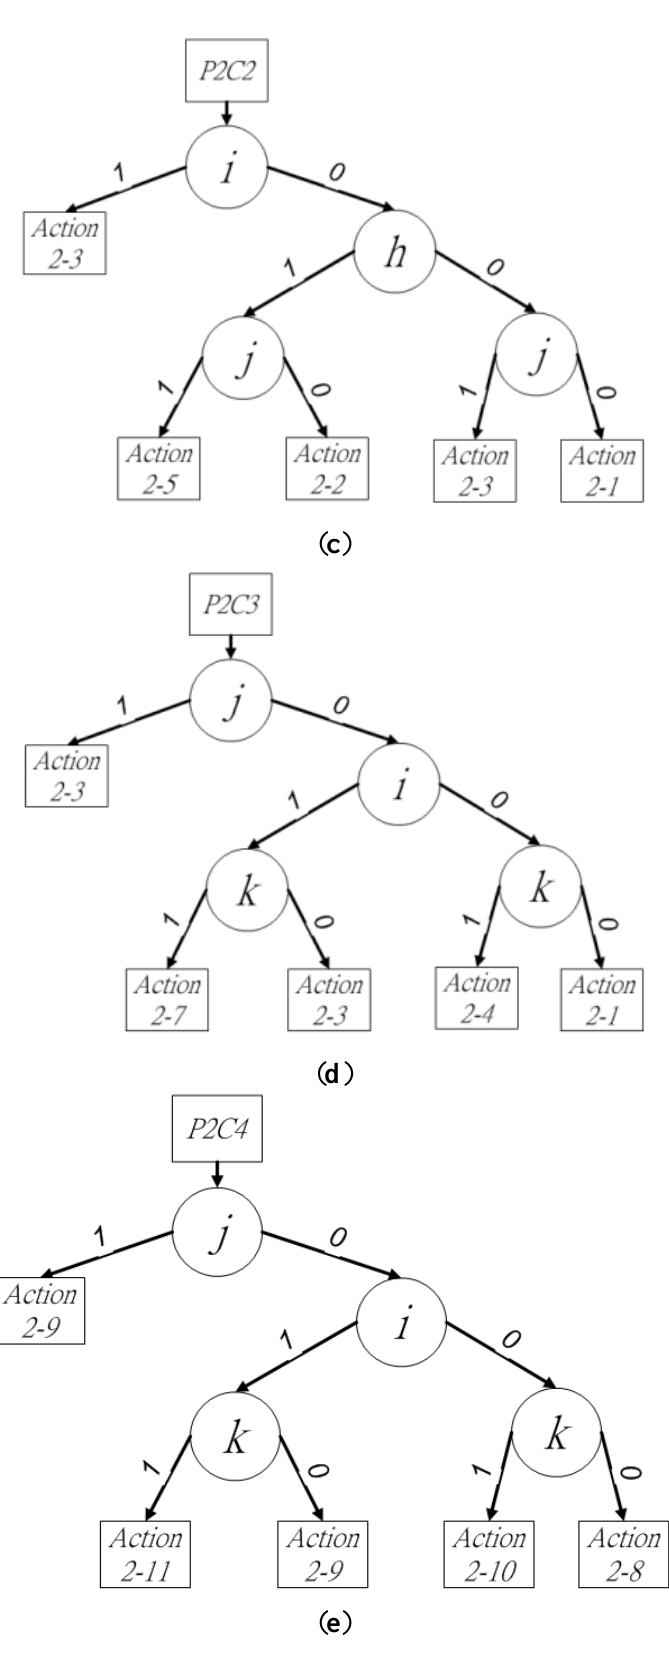
Figure 6. Binary decision tree of ( a ) procedure 2, ( b ) P2C1 , ( c ) P2C2 , ( d ) P2C3 , and ( e ) P2C4